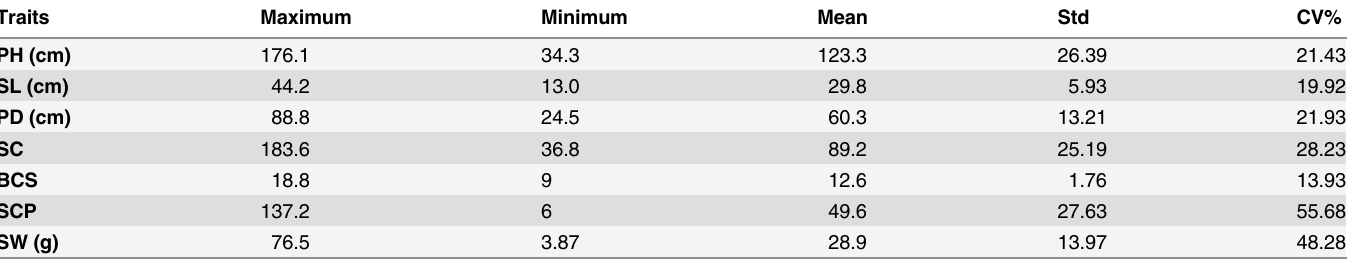
Table 1. Range of plant height (PH), spike length (SL), pulvinus distance (PD), spikelet count (SC), branch count per spike (BCS), spike count per plant (SCP), spike weight (SW) for 115 tall fescue accessions. Traits